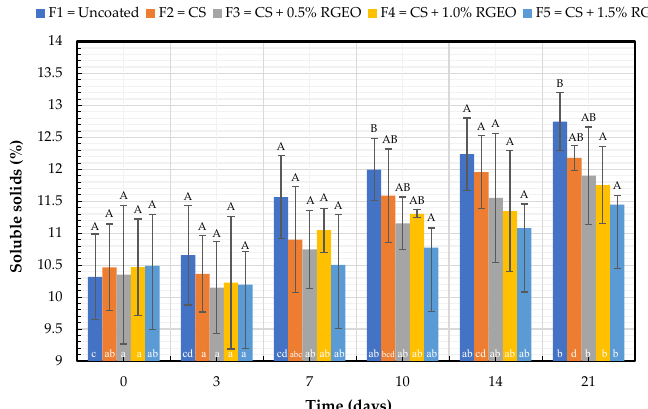
Figure 3. Evolution of the total soluble solids content by total de SS measurement pears with CS + RGEO treatments: F1 = uncoated, F2 = CS, F3 = CS + RGEO 0.5%, F4 = CS + RGEO 1.0%, and F5 = CS + RGEO 1.5%. According to the ANOVA test, mean values and intervals of Duncan test for treatments and Fisher for days with 95%. Different lowercase letters (a, b, c) indicate significant differences between days according to the LSD Fisher test for each treatment in a confidence interval of 95%. In contrast, different uppercase letters (A, B, C) indicate significant differences between treatments for each day according to the Duncan test in a confidence interval of 95%.